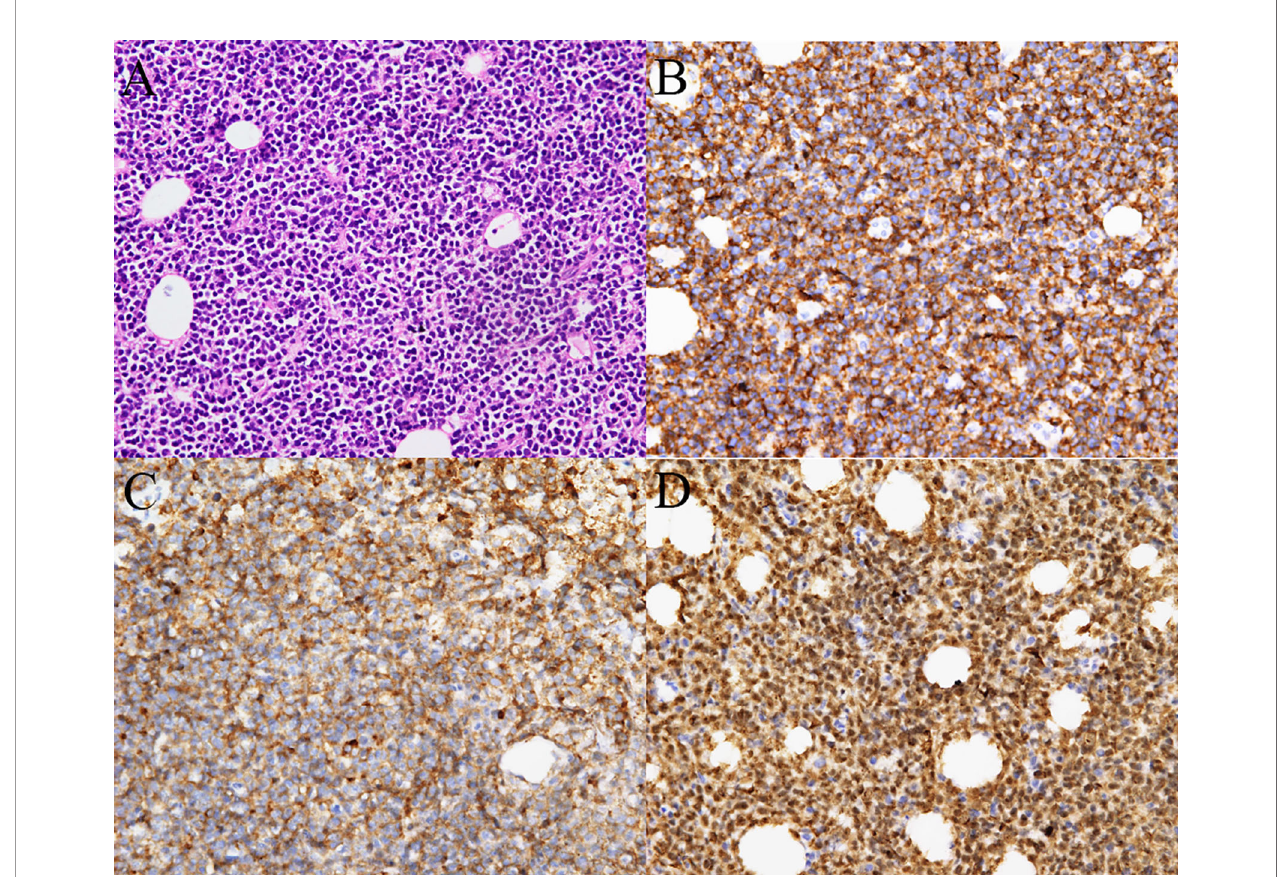
FIGURE 2 | Histopathology from the omental thickening biopsy. (A) Hematoxylin-eosin staining showed diffuse in fi ltration of neoplastic lymphoid cells (400×). Tumor cells were immunoreactive for (B) CD20, (C) CD10, (D) and expressed high Ki-67 index (nearly 90%)